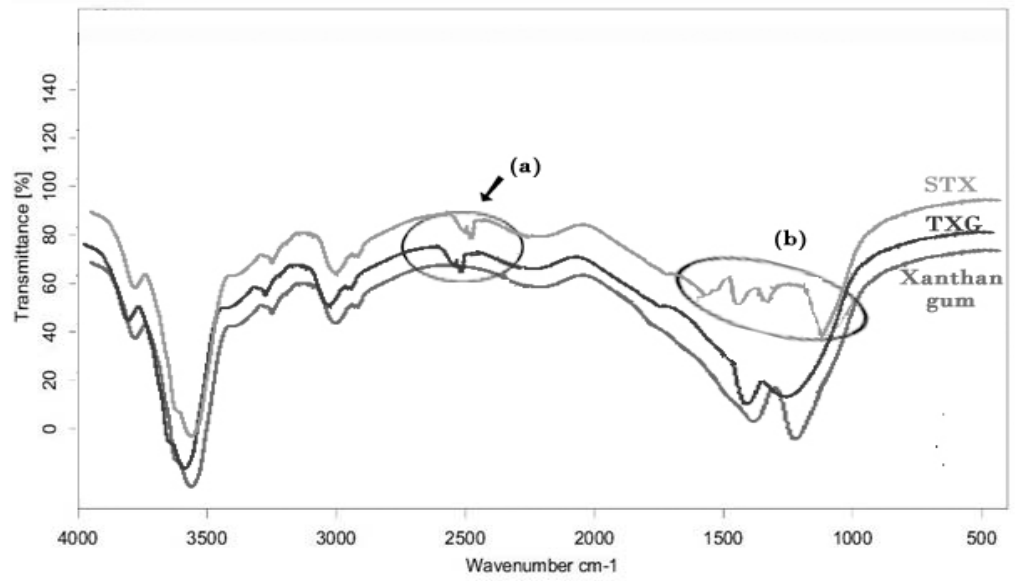
Figure 4. FTIR spectra of xanthan gum, TXG and STX. (a) confirms the presence of thiol groups in TXG and STX and (b) represents the S ‐ Protected groups of STX.